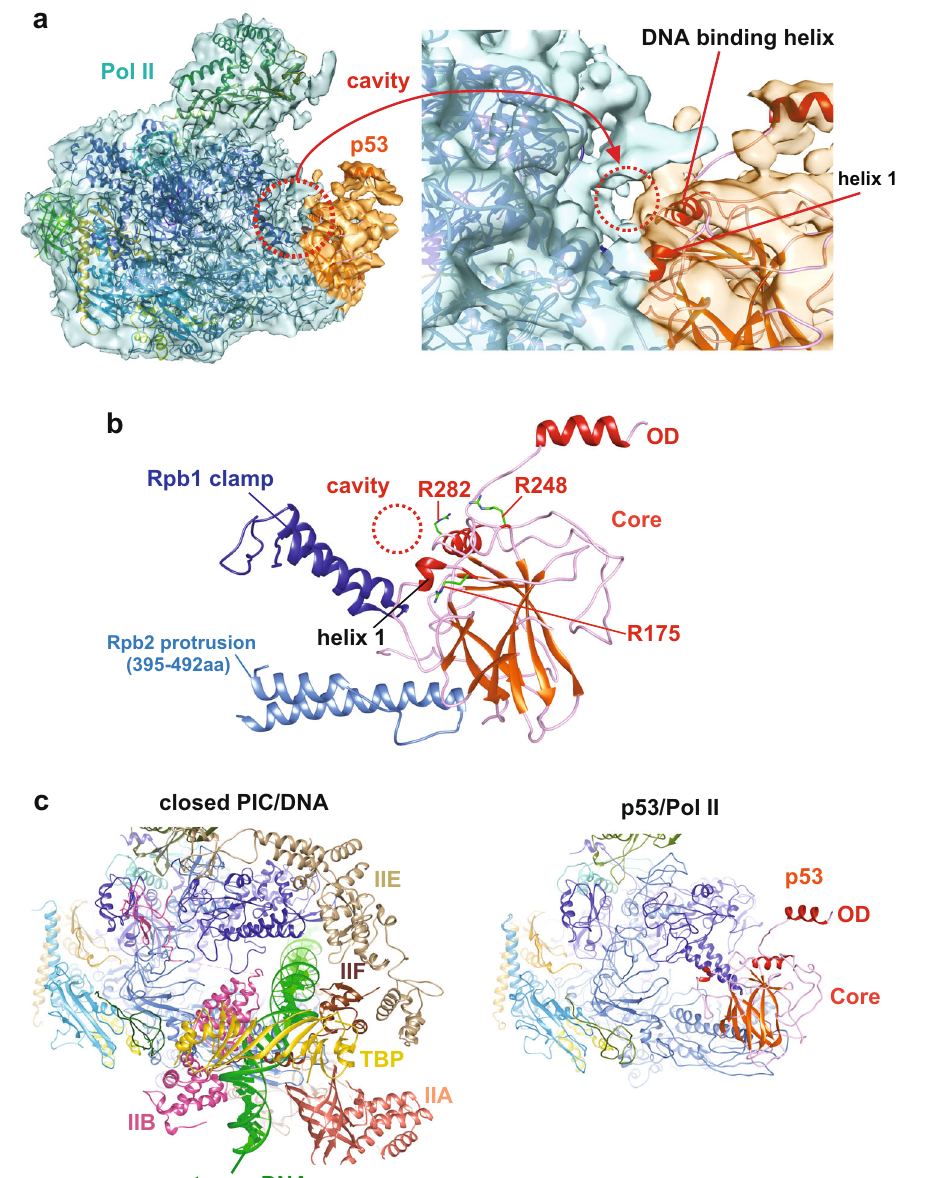
Fig. 2 Structural features of the p53 core domain when bound to Pol II. a An overlay of cryo-EM density and p53/Pol II molecular structure is shown (left panel). A zoomed view highlights the p53 core domain and Pol II interface (right panel). The p53 core domain/Pol II cavity (red circle) is formed upon their interaction. The key DNA binding helix and helix 1 of the p53 core domain are indicated. b The molecular structure of the p53 core domain and Pol II around the interface is presented. The cavity is positioned in between Pol II ’ s Rpb1 clamp and DNA binding helices of the p53 core domain. Three hot-spot oncogenic residues (i.e., R175, R248 and R282, frequently mutated in cancer patients) 9,29 , critical for sequence-speci fi c DNA binding, are located around the surface of the core domain/Pol II cavity. c The structure of the closed PIC (PDB: RCSB 5IYA 6 , left panel) shows the positioning of Pol II and upstream DNA/GTFs, in comparison with the contact surfaces of p53-bound Pol II (right panel). The p53 core domain occupies the regions of Pol II in the vicinity of upstream DNA, TBP, TFIIA and TFIIB (compare both